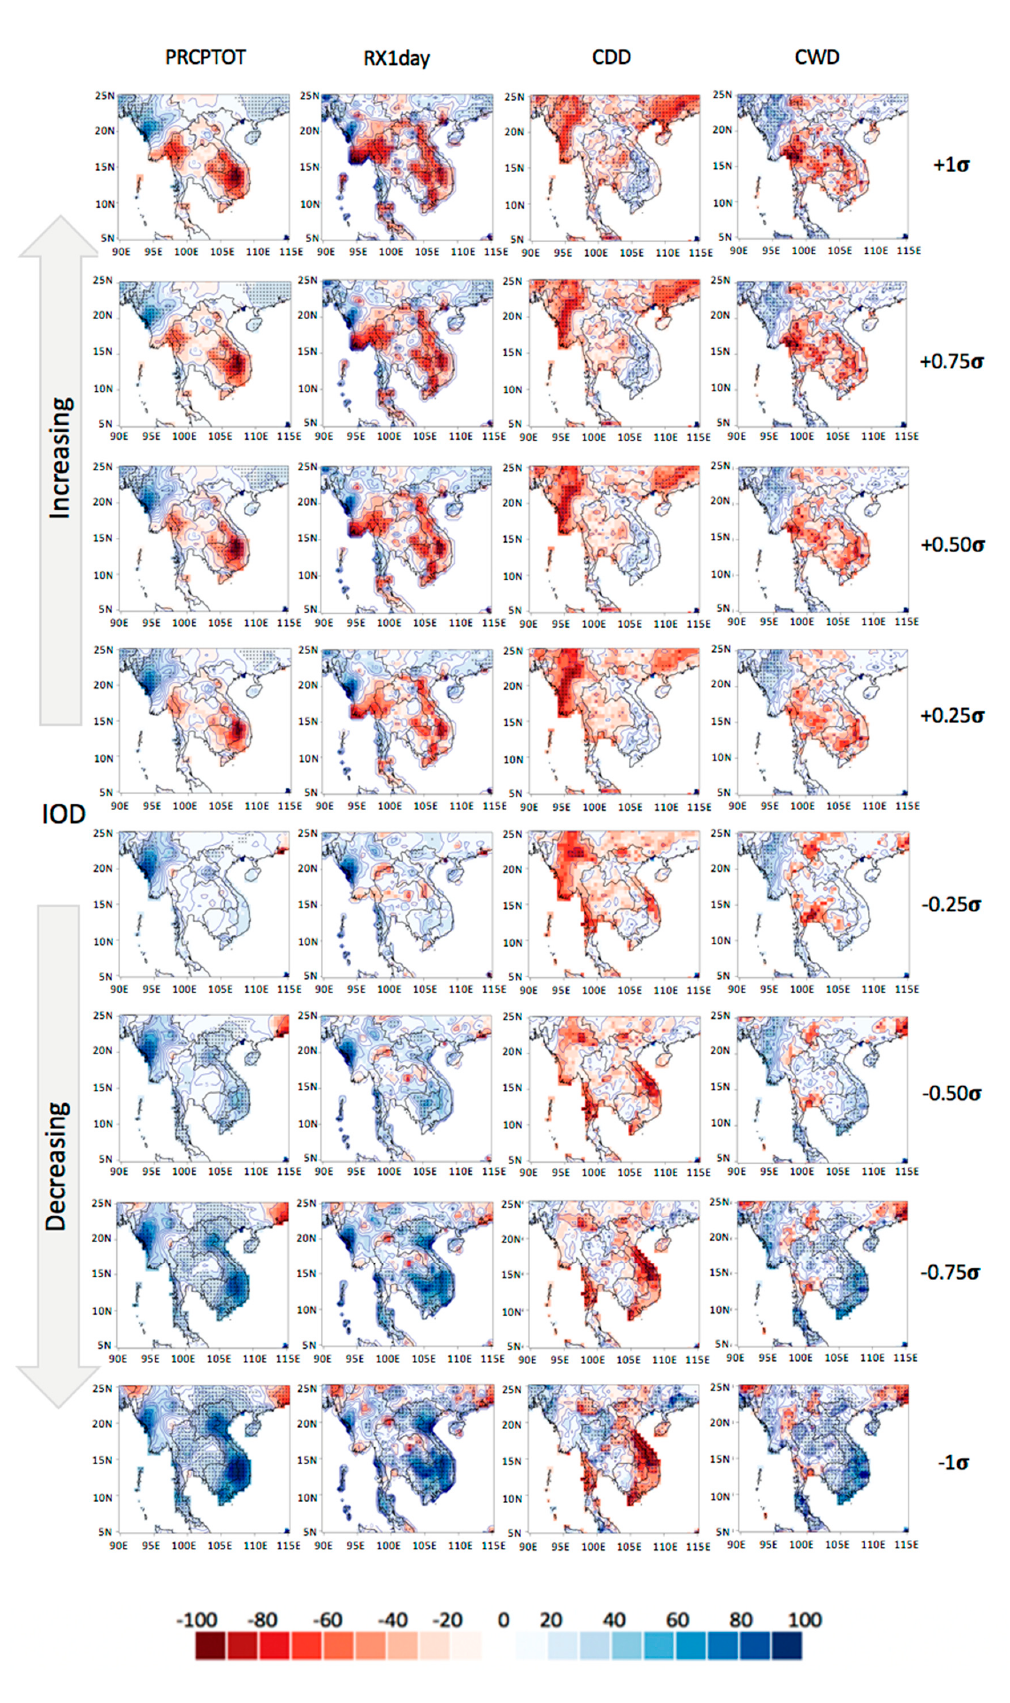
2 Figure 11. Same as Figure 10, but for the dry season (November–April) over the ICP